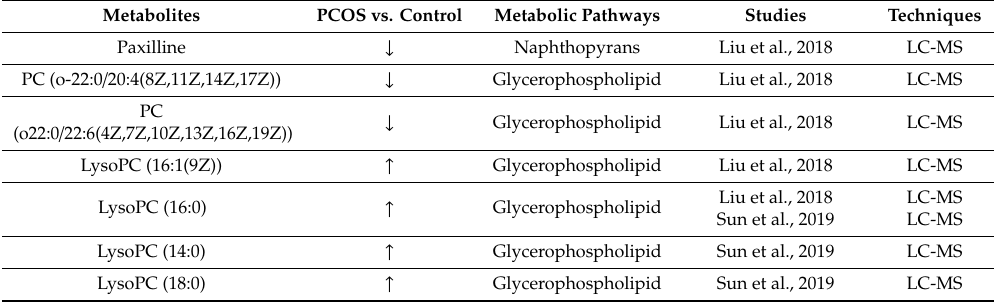
Table 3. The most significant changes in FF metabolites in women with PCOS in comparison with the control